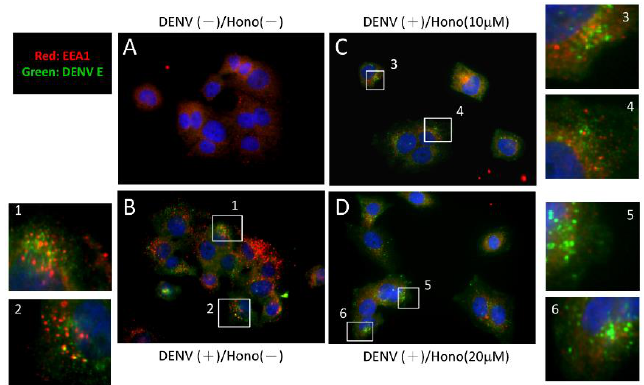
Figure 5. Honokiol may interfere with the endocytotic pathways of DENV entry. Huh7 cells were ( A ) mock or ( B ) infected with dengue virus at MOI of 10. The DENV-infected cells were treated with ( C ) 10 and ( D ) 20 μM of honokiol for 1.5 h. Immunofluorescence staining was conducted to detect the DENV E protein (green fluorescence) and the early endosome marker, EEA1 (red fluorescence). Numbered side squares represent the magnified images of areas in corresponding panels.